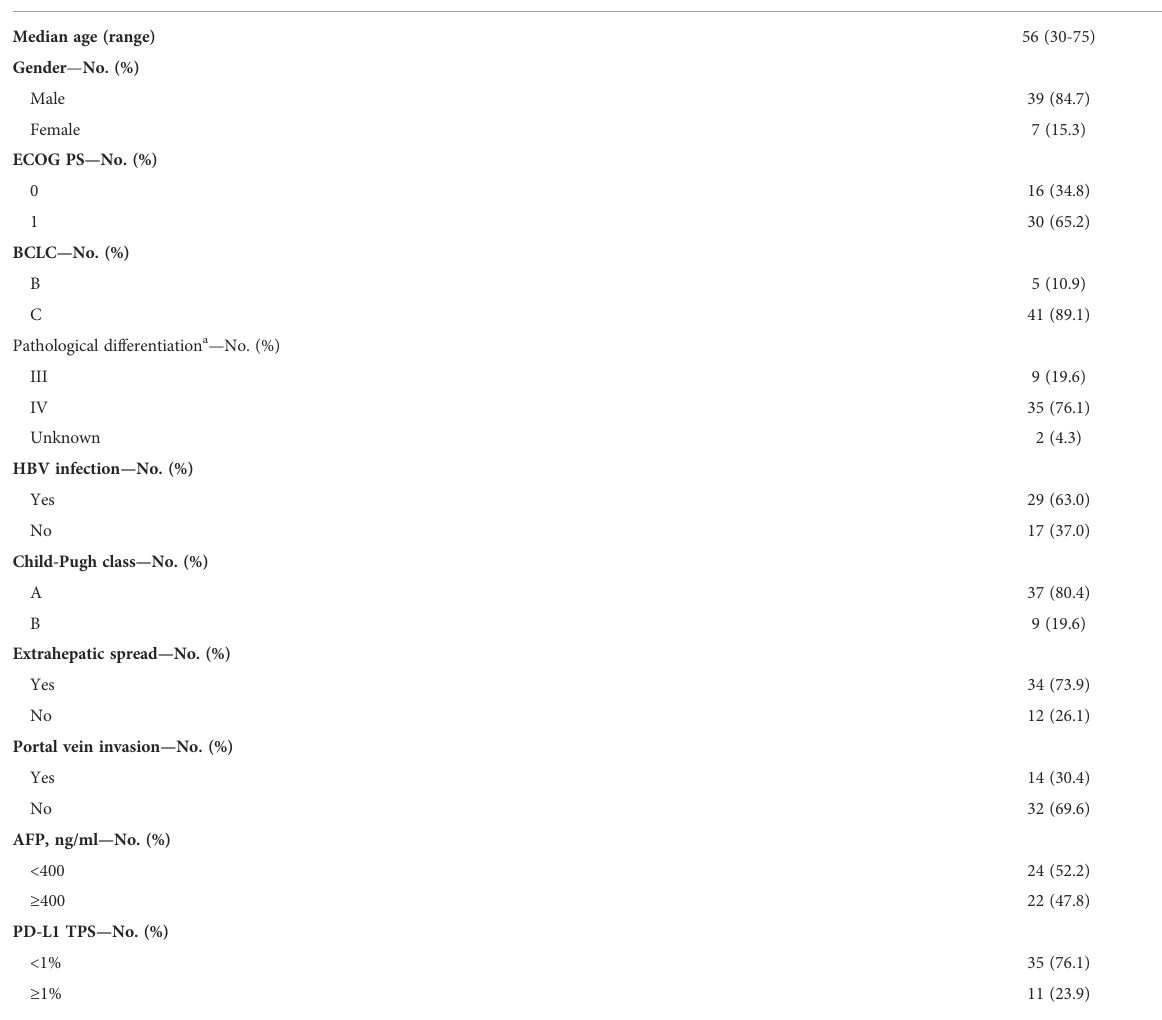
TABLE 1 Baseline clinical characteristics.